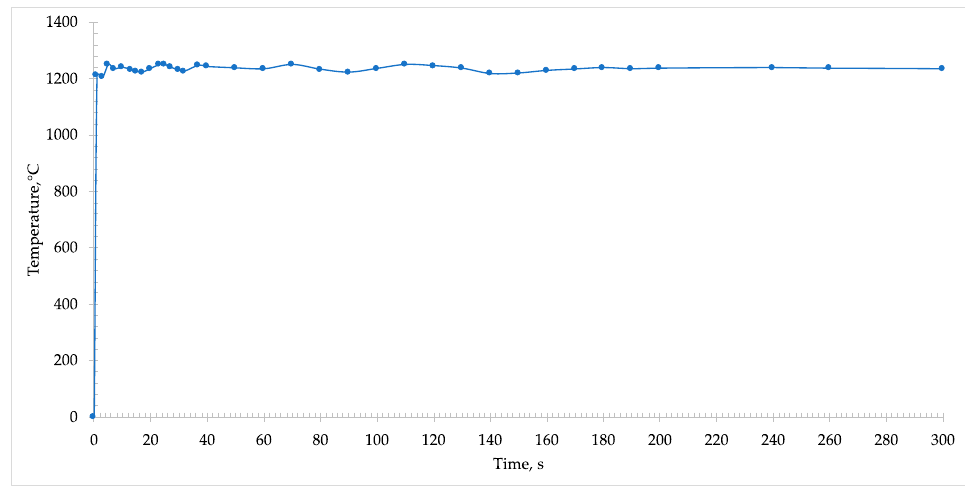
Table 4. Chemical analysis of bauxite residue, sinter and leaching residue (MBR).